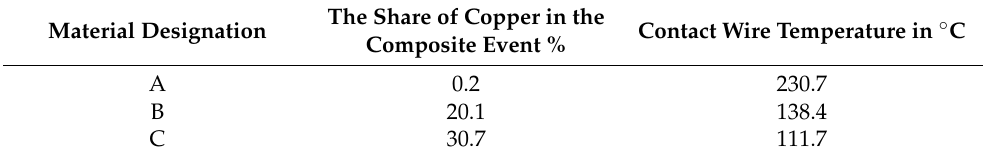
Table 2. Temperatures of contact wire for various copper concentrations in the material of contact strips [21].